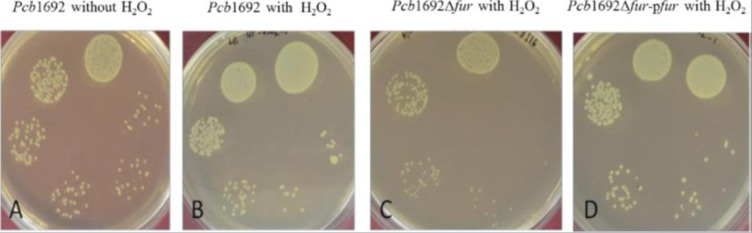
The effect of H2O2 on Pcb1692 wild-type and mutant strain survival.(A) Pcb 1692 wild-type cultured in LB medium (B) Pcb1692 wild-type in LB medium supplemented with H2O2 (C) Pcb1692Δfur mutant strain cultured in LB supplemented with H2O2 (D) Pcb1692Δfur-pfur cultured in LB supplemented with H2O2.